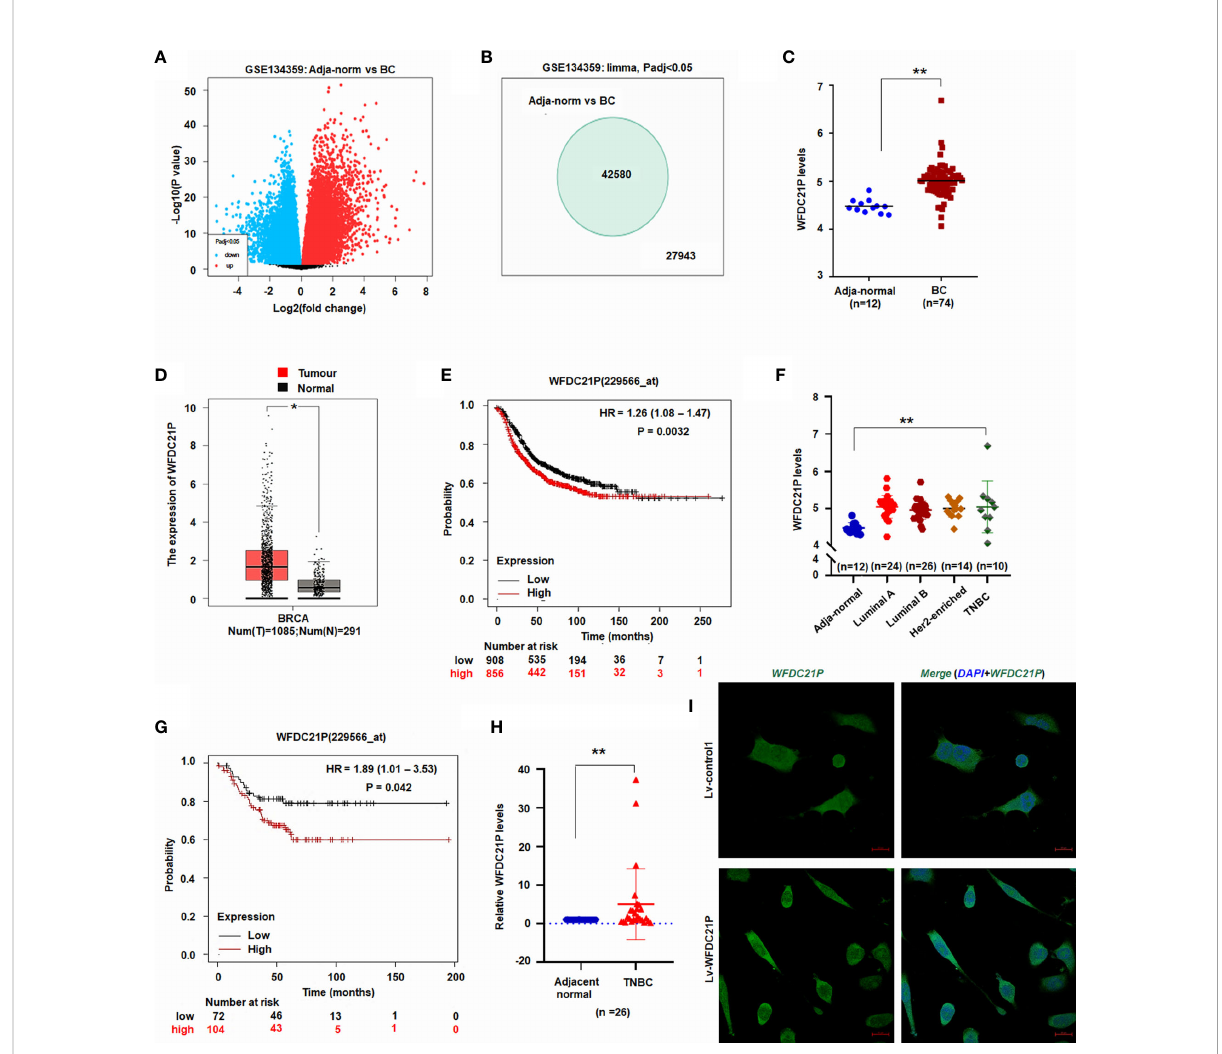
FIGURE 1 Expression of WFDC21P in BC. (A) Volcano plot of lncRNA microarray datasets GSE134359. (B) Number of different lncRNA gene expression. (C) WFDC21P expression between BC and adjacent normal tissues from GSE134359. Data are shown as median (interquartile range), ** p < 0.01, Mann – Whitney U test. (D) WFDC21P levels were higher in BC tissues. BC tissues, n=1085; normal tissues, n=291; * p < 0.05. (E) Kaplan – Meier plotter analysis of the overall survival of patients with BC. (F) WFDC21P levels were higher in TNBC tissues than in normal adjacent tissues from GSE134359. Normal, n = 12; Luminal A, n = 24; Luminal B, n = 26; Her2-enriched, n = 14; TNBC tissues, n = 10; Kruskal – Wallis H tests, ** p < 0.01. (G) Kaplan – Meier Plotter analysis of the overall survival of patients with TNBC. (H) WFDC21P expression was estimated by qRT-PCR in TNBC tissues (n = 26) and adjacent normal tissues. Data are shown as median (interquartile range), ** p < 0.01; n=26, Mann – Whitney U test. (I) In situ hybridization detection of WFDC21P. Green color in cell indicates the expression of WFDC21P. bar = 20 m